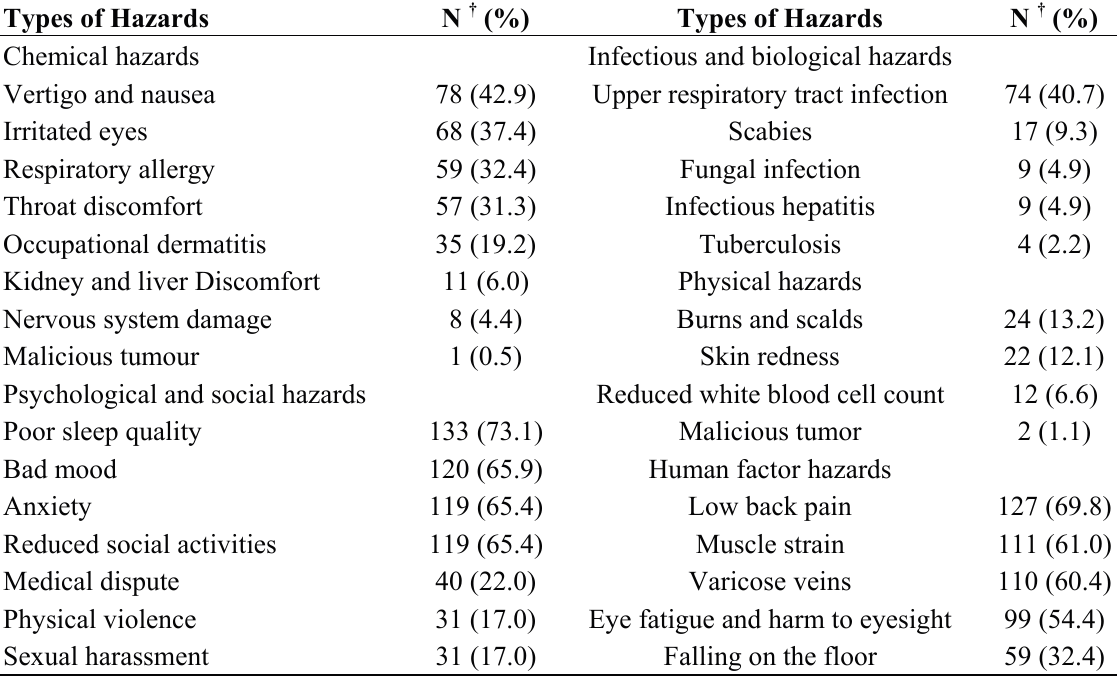
Table 3. Research subjects’ experiences of occupational